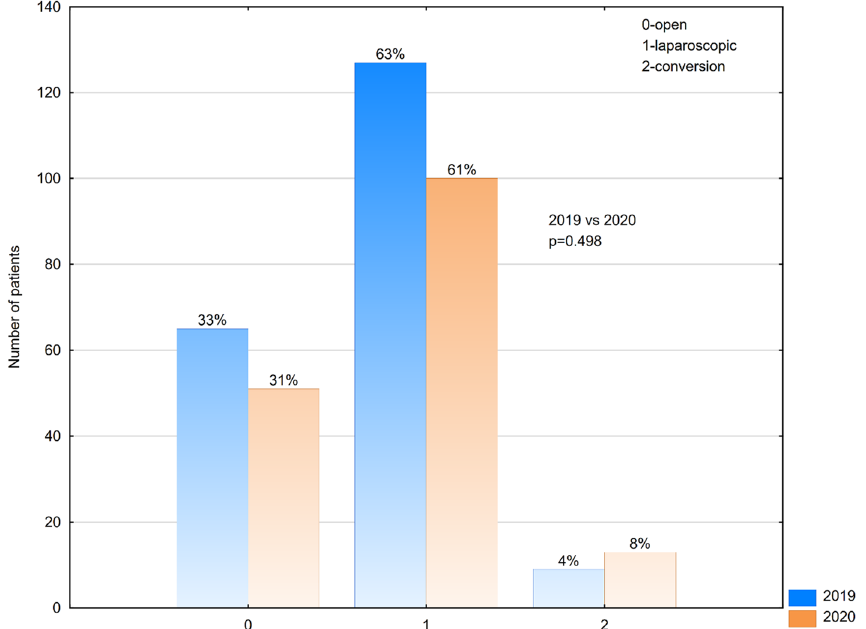
Figure 4. Type of surgical approach among patients treated with appendectomy in 2019 and 2020.